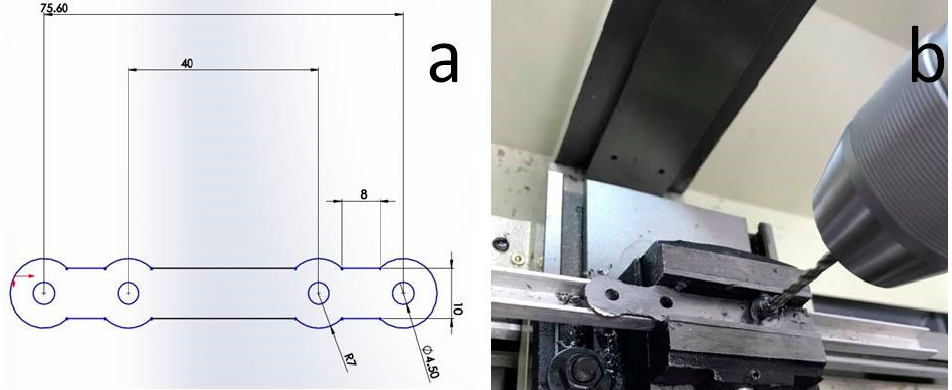
Figure 14. ( a ) Technical drawing of the bone plate and ( b ) intermediate shape drilling, according to technical drawing specifications.